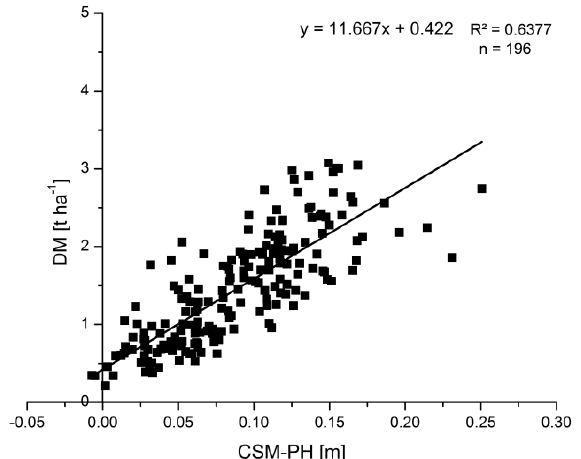
Figure 3. Plant height from Crop Surface Model (CSM-PH) versus dry matter (DM), Growth 2 & 3 (A2 & A3)